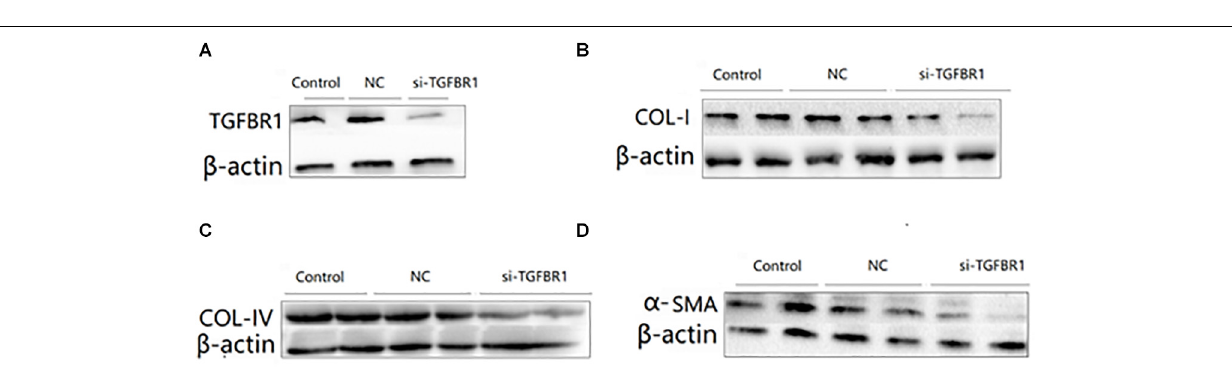
FIGURE 6 | The effects of TGFBR1 knockdown on TGF- β 1-induced collagen accumulation and cell differentiation in HK2 cells. HK2 cells were transfected with si-TGFBR1 or NC, and then treated with TGF- β 1 (5 ng/ml) for 24 h. The knock down effects of si-TGFBR1 was confirmed by Western blot (A) . The protein expression of COL-I (B) , COL-IV (C) , and α -SMA (D) was determined by Western blot. β -actin was detected as a loading control. Data was presented as mean ± SD of three experiments. Control: no transfection treatment, Negative control (NC): cells transfected with scrambled